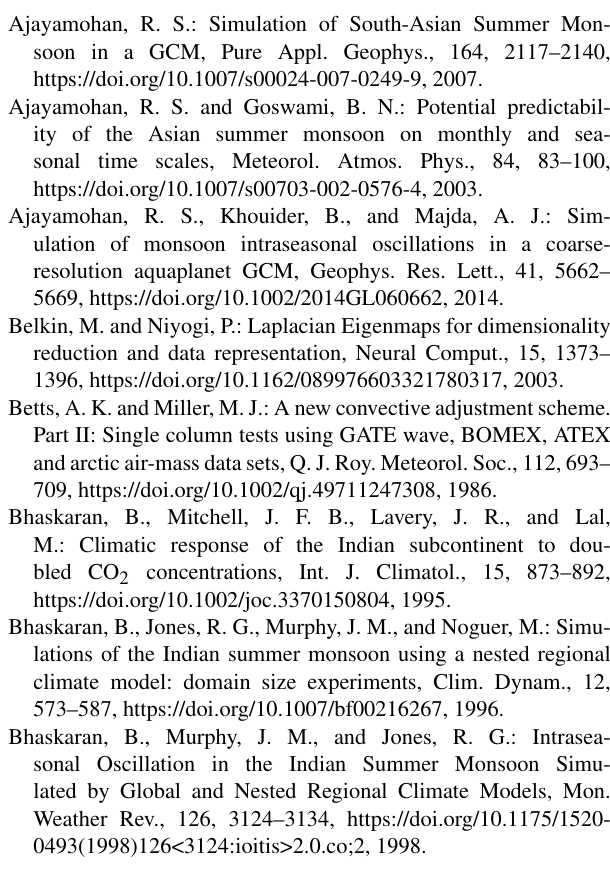
Figure 16. Temporal evolutions of (a) KELLF indices, (b) precip- itable water averaged over the Indian subcontinent, and (c) daily surface precipitation averaged over the Indian subcontinent in year 2007 from ERA-Interim/TRMM (black lines), WRF-gray sim- ulation starts from 20 April (blue lines, control run), WRF-gray sim- ulation starts from 19 April (red lines), and WRF-gray simulation starts from 21 April (green